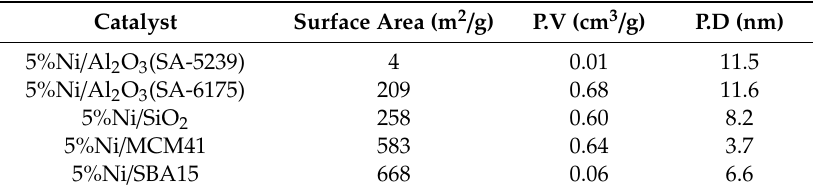
Table 1. N 2 physisorption results for the di ff erent